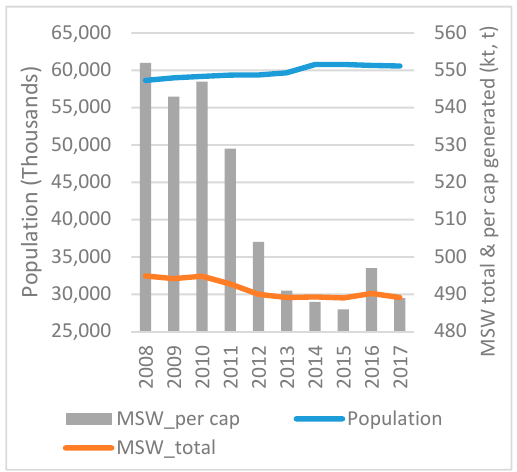
Figure 23. Population and MSW production in Italy 2008–2017 (EUROSTAT 2019a, 2019c). Soc. Sci. 2019 , 8 , x FOR PEER REVIEW